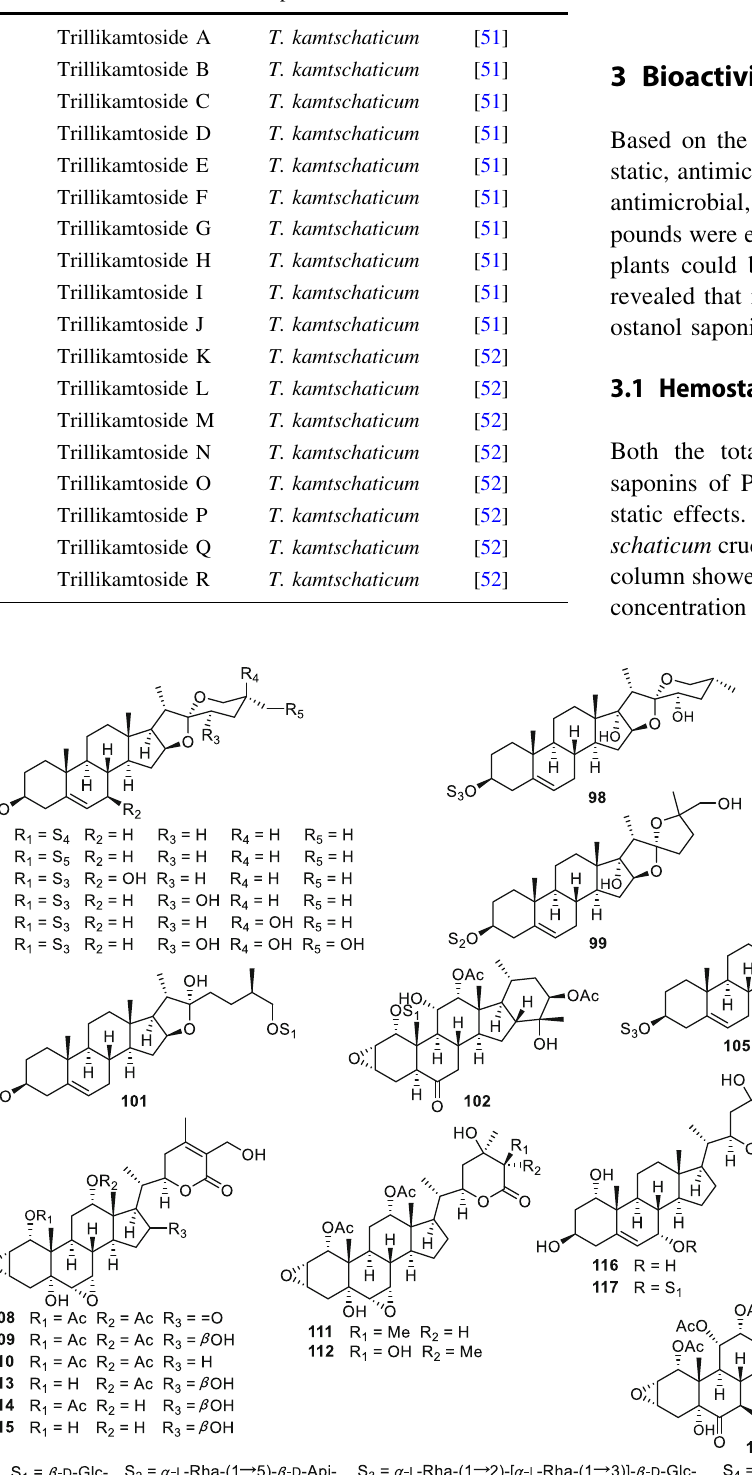
Table 3 New steroidal saponins from the whole plants of T. kamtschaticum No.